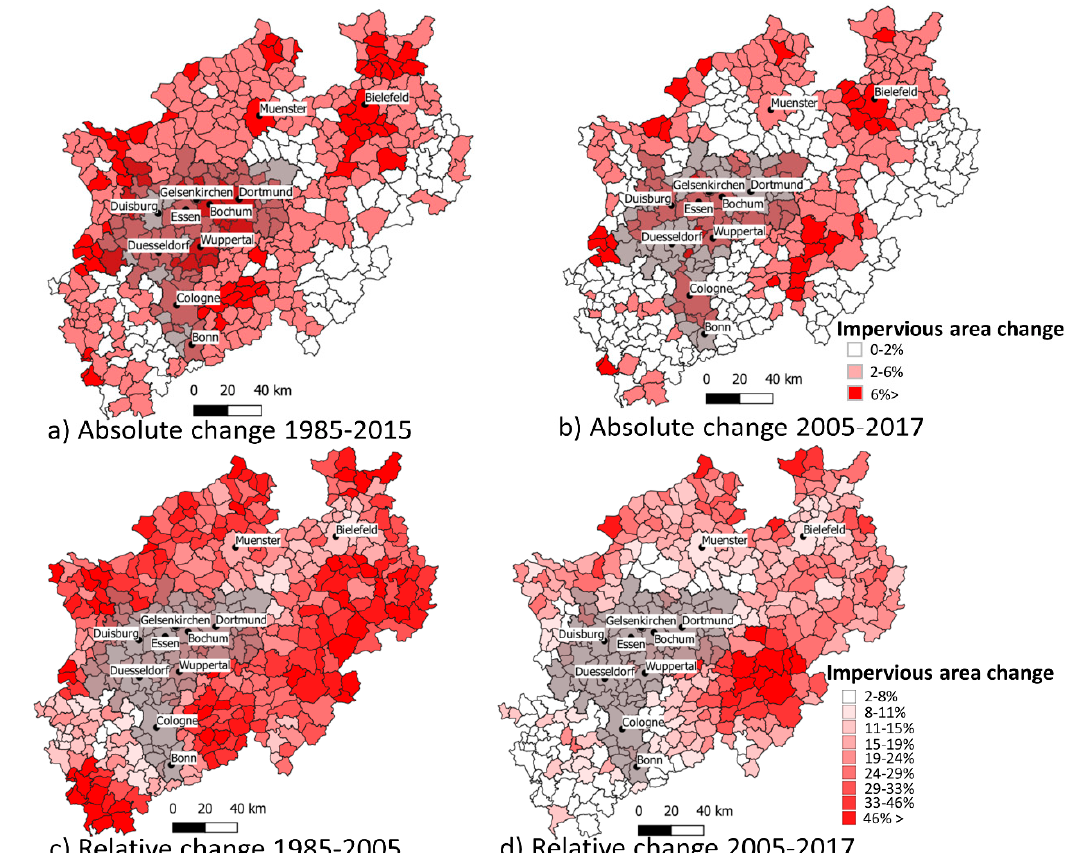
Figure 6. Changes in urbanization in NRW: Absolute change in between 1985–2005 ( a ) and 2005–2017 ( b ) and relative change between 1985–2005 ( c ) and 2005–2017 ( d ).